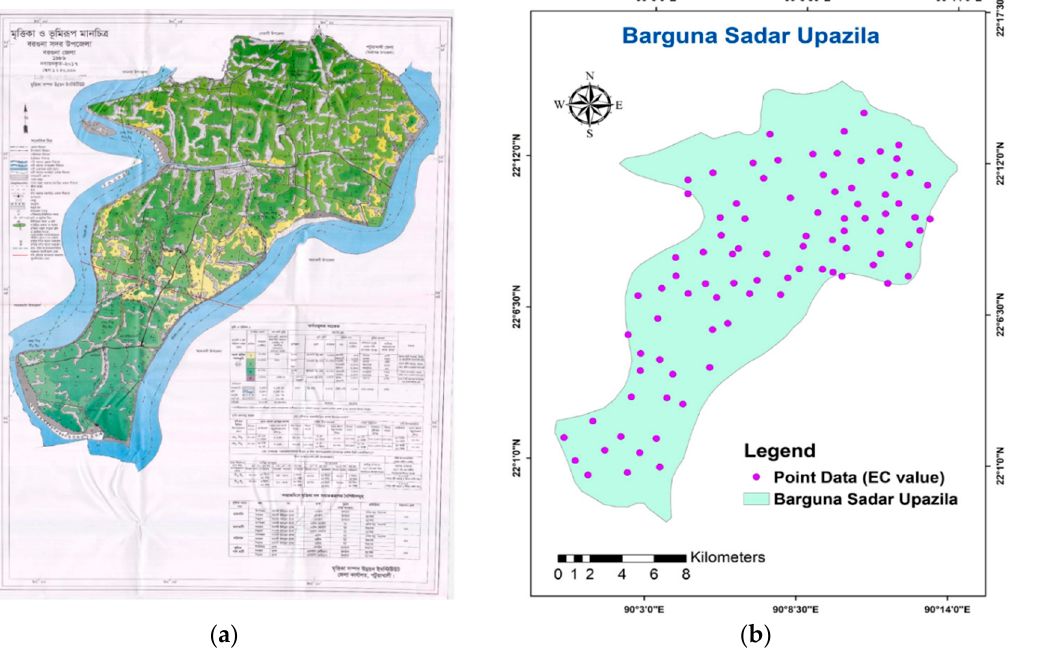
Figure 3. ( a ) Barguna Sadar Upazila (Sub-district) scanned map; ( b ) Generated point shapefile for Barguna Sadar Upazila.